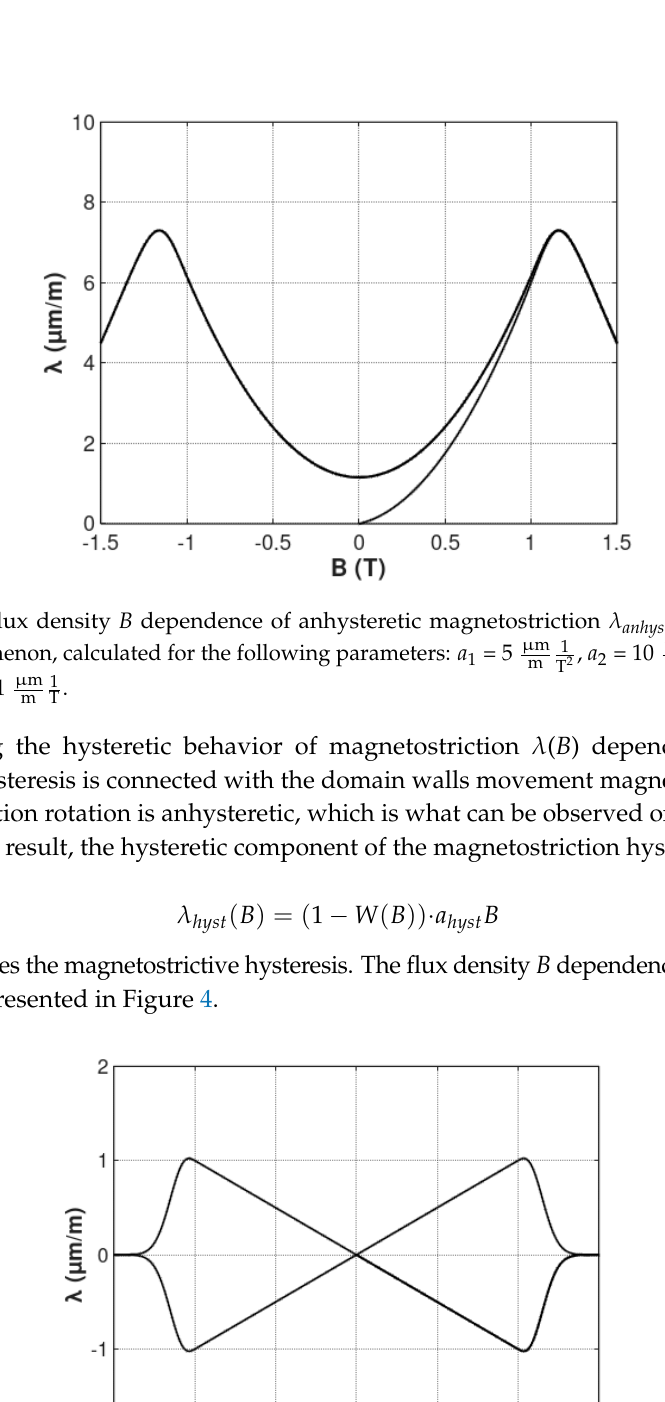
(cid:2869) . 1 (cid:2869) (cid:2923) (cid:2904) m T . (cid:2923) (cid:2904)